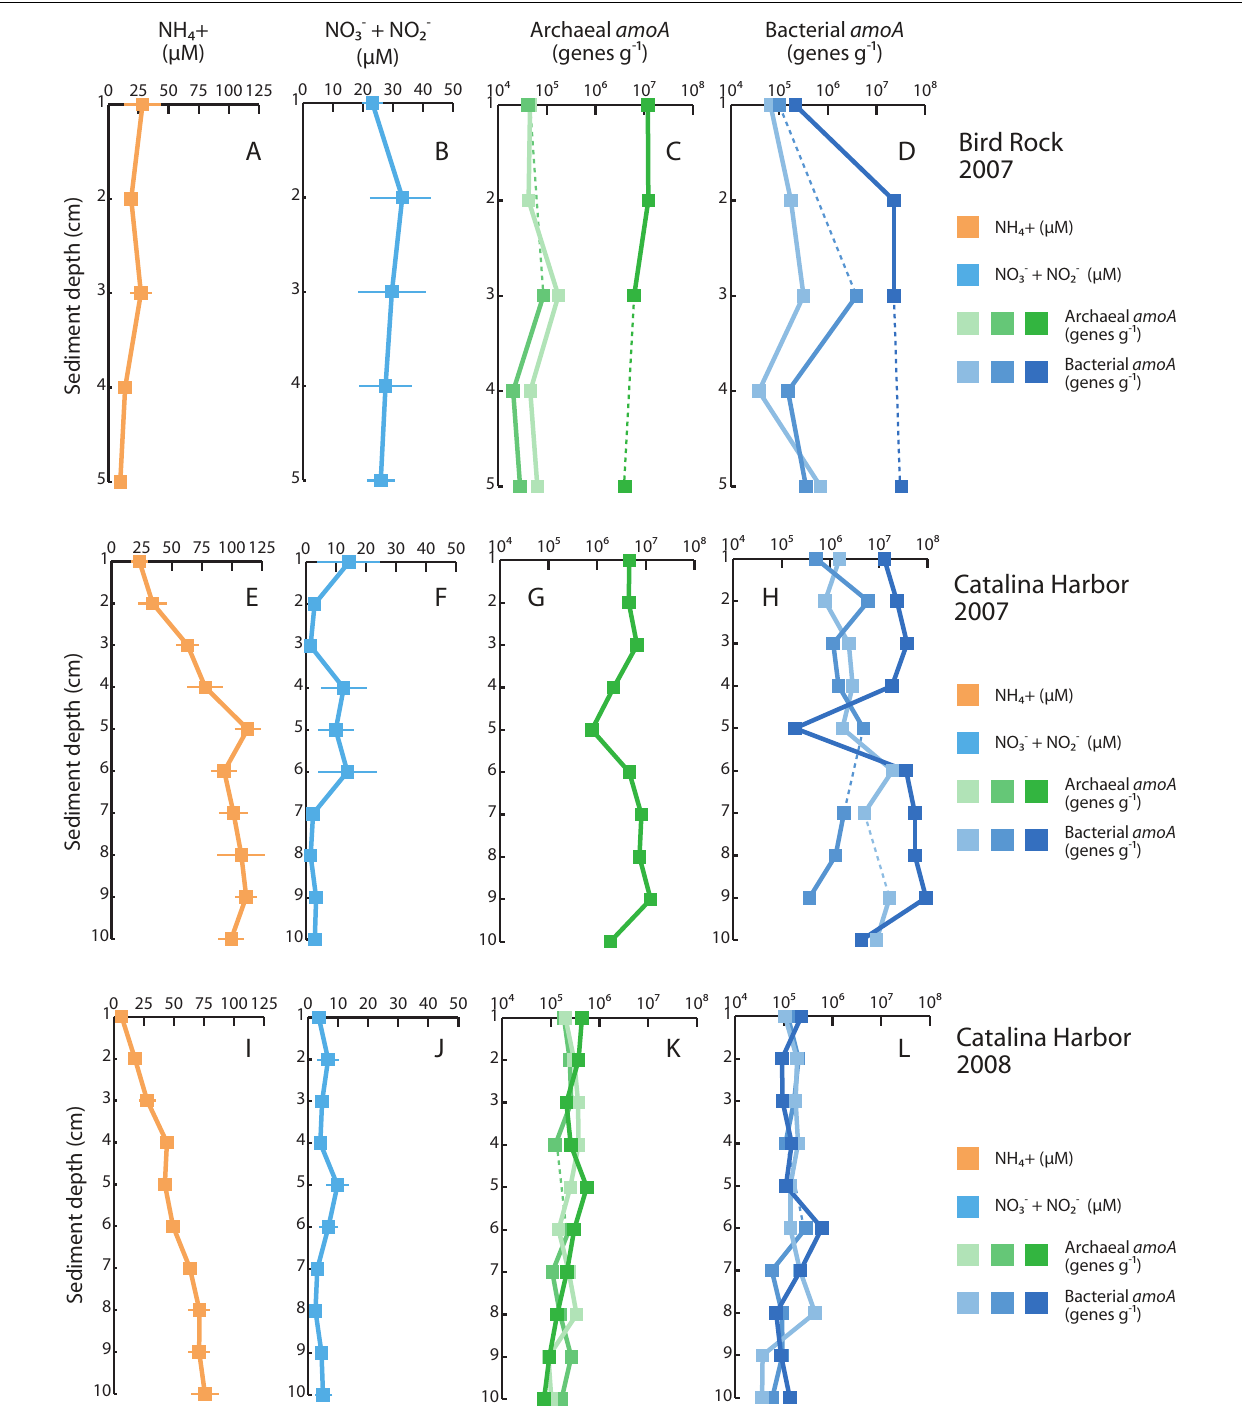
are shown for individual cores collected at Bird Rock (D) , Catalina Harbor in 2007 (H) , and Catalina Harbor in 2008 (L) . In (C–L) , dashed lines denote depths were data values are omitted due to qPCR inhibition of samples, and color shading denotes different cores. Light green/light blue denotes BR1 (C,D) , CH1 (G,H) , and CH4 (K,L) ; “mid” green/“mid” blue denotes BR2 (C,D) , CH2 (G,H) , and CH5 (K,L) ; dark green/dark blue denotes BR3 (C,D) , CH3 (G,H) , and CH6 (K,L) . In (G) , archaeal amoA was only detectable in one